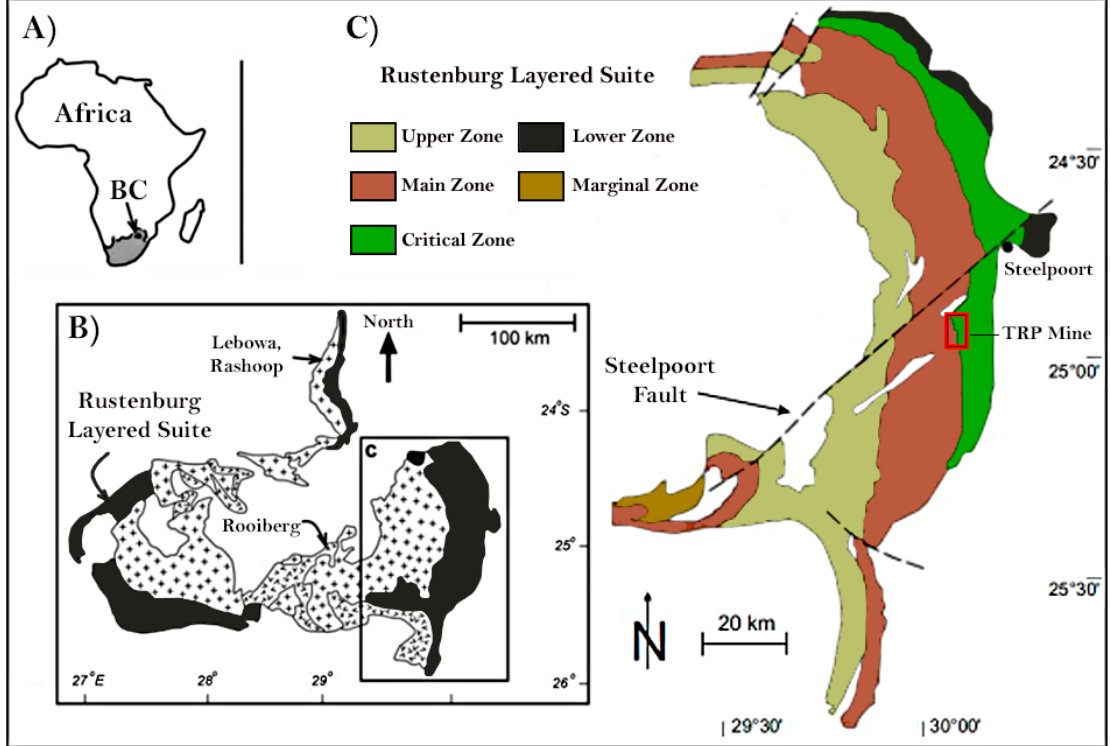
Figure 1. ( A ) Location map of the Bushveld Complex (BC) in South Africa. ( B ) Geological map that shows the distribution of the Rustenburg Layered Suite along with felsic units (Lebowa, Rashoop and Rooiberg) within the Bushveld Complex. ( C ) Geological map of the Eastern limb of the Bushveld Complex. The red box indicates the location of the sampling site at the Two Rivers Platinum (TRP) Mine. Modified after Voordouw and Beukes [34] .